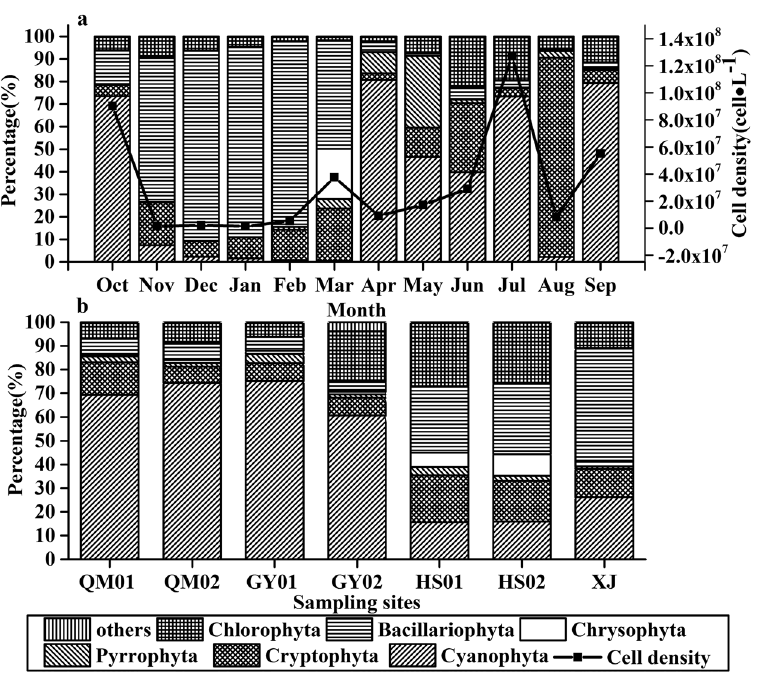
Figure 3. Seasonal ( a ) and spatial ( b ) variations of algal composition and algal cell density in the Xiaojiang